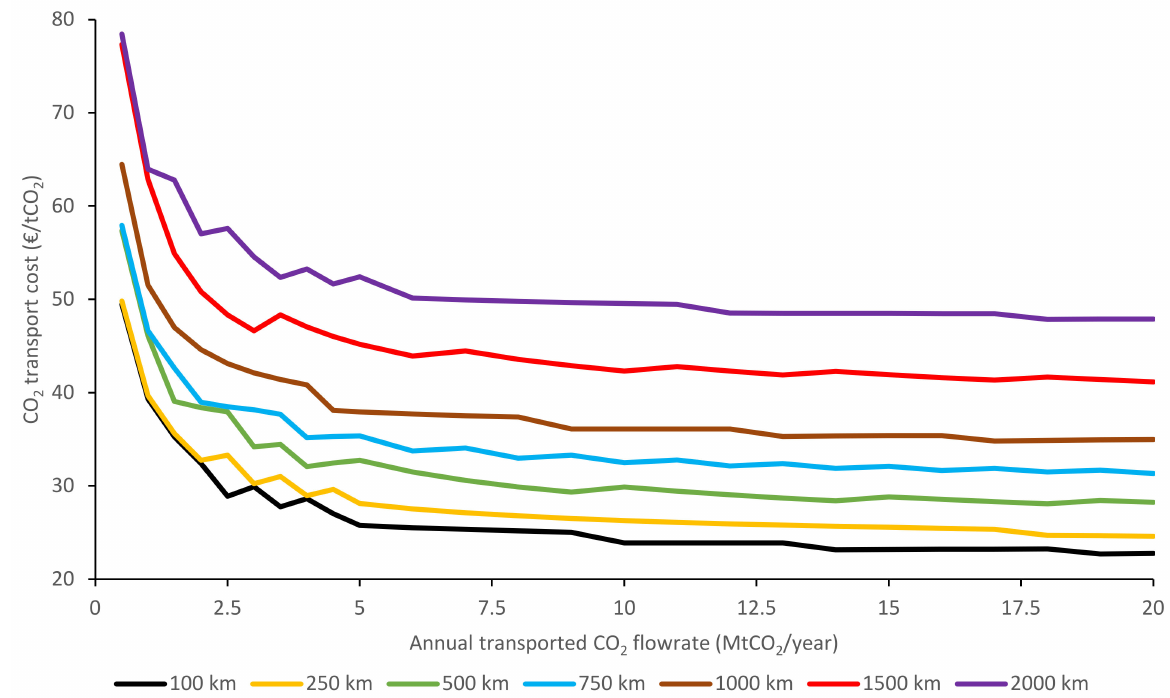
Figure A5. CO 2 conditioning and transport costs as a function of transport distance and annual volume when transporting pure CO 2 to an offshore site by ship at 15